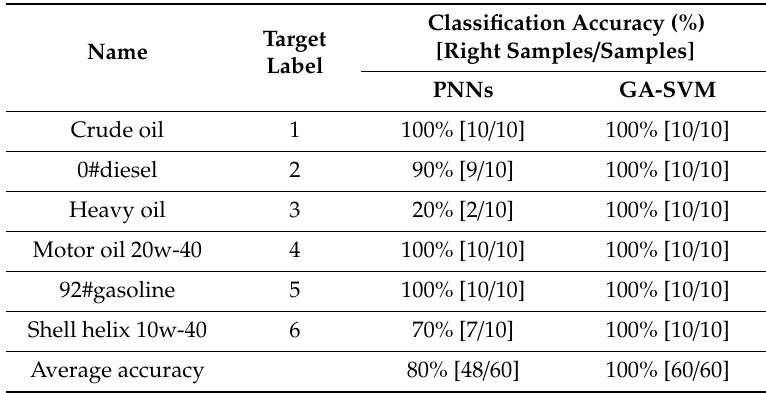
Figure 3. Results of actual classification and predicted classification of PNNs and GA-SVM. Table 2. Test set classification results by PNNs and GA-SVM.